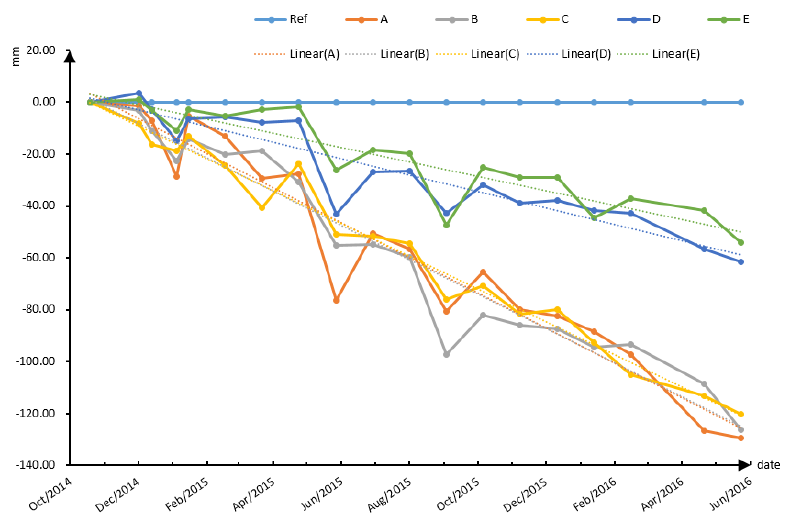
Figure 7. Cumulative deformation of the line